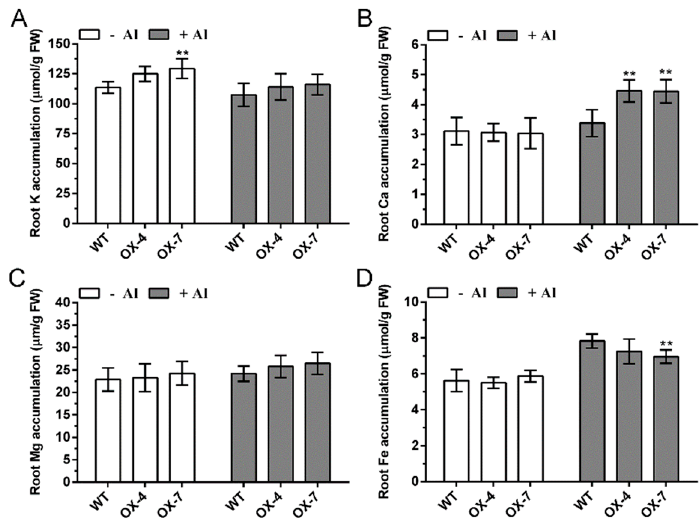
Figure 6. Concentration of other metals in transgenic Arabidopsis overexpressing GmIREG3 . Arabidopsis plants were exposed to 0 or 10 µM Al solution for 2 d and then subjected to determination of K ( A ), Ca ( B ), Mg ( C ) and Fe ( D ). Data are means ± SD ( n = 3). Significant differences according to the one-way analysis of variance are denoted as follows: ** p < 0.01.